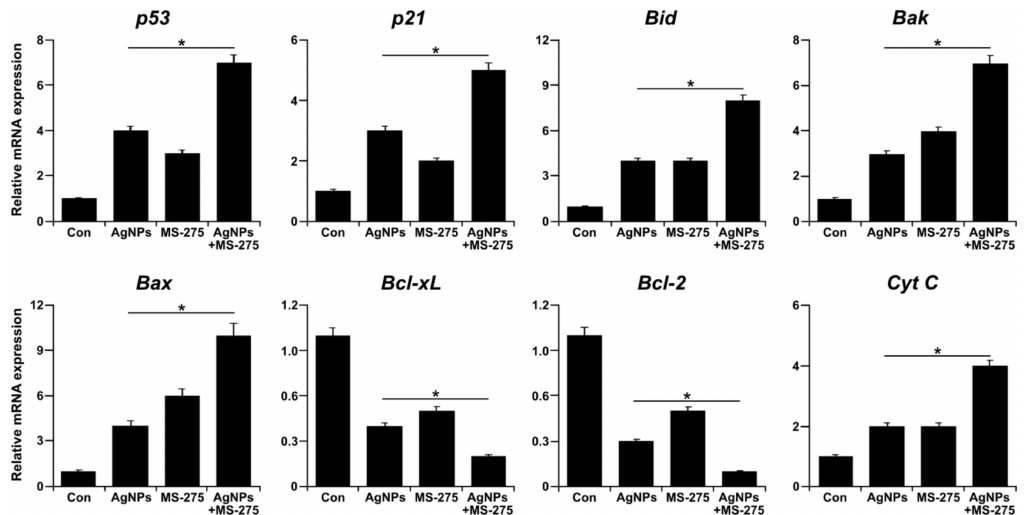
Figure 10. Effect of AgNPs and MS-275 on expression of apoptotic and anti-apoptotic genes in A549 cells. A549 cells were incubated with AgNPs (1 µ M), MS-275 (1 µ M), or a combination of AgNPs (1 µ M) and MS-275 (1 µ M) for 24 h. Relative mRNA expression was analyzed by qRT-PCR after the treatments. The results are expressed as the mean ± standard deviation of three independent experiments. The treated groups showed statistically significant differences from the control group by Student’s t -test. * p <